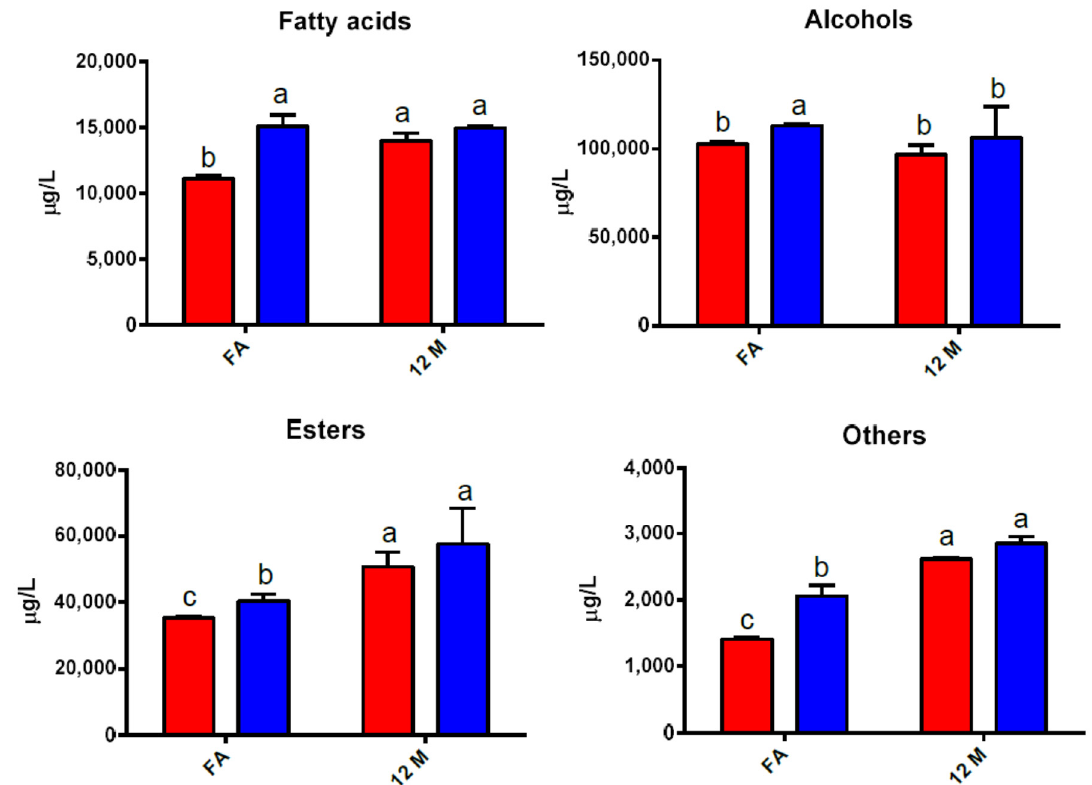
Figure 2. Concentrations ( μ g/L) of volatile compounds grouped by chemical family after secondary alcoholic fermentation (2nd AF) and after 12 months of storage “sur lie.” Different letters indicate significant differences according to Tukey’s test ( p < 0.05). n = 3.